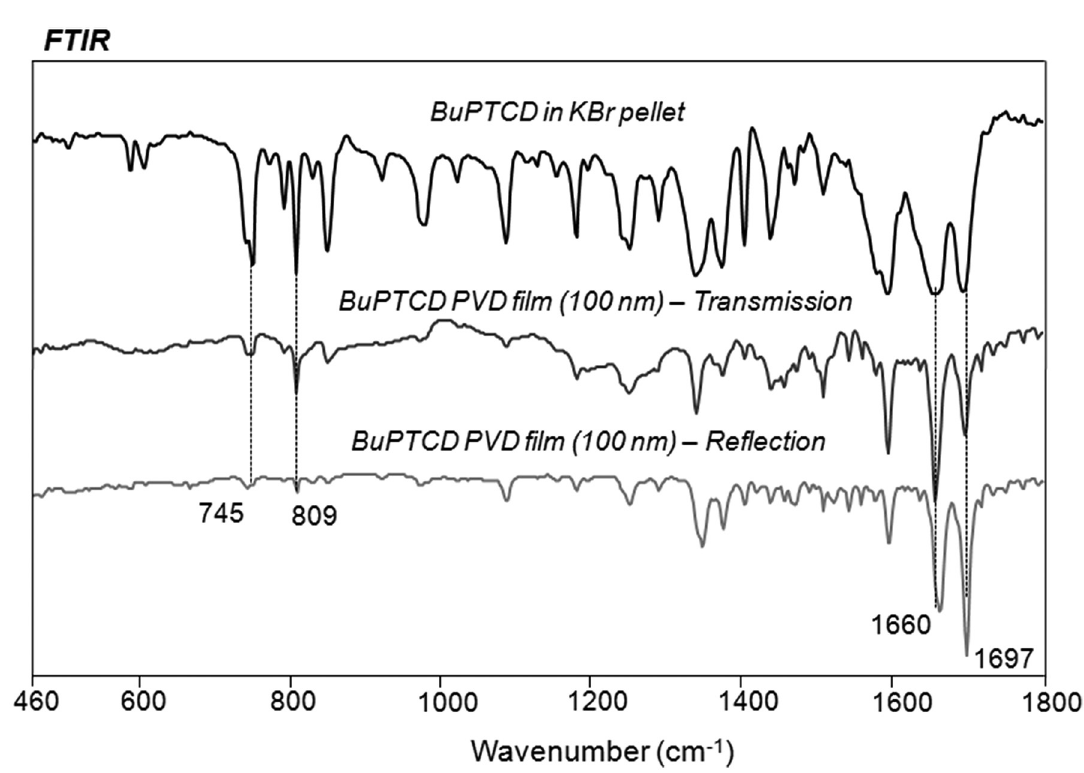
Figure 4. Topographic AFM images (2D and 3D) showing the profile along an edge, made by scratching the 100 nm PVD film of BuPTCD.